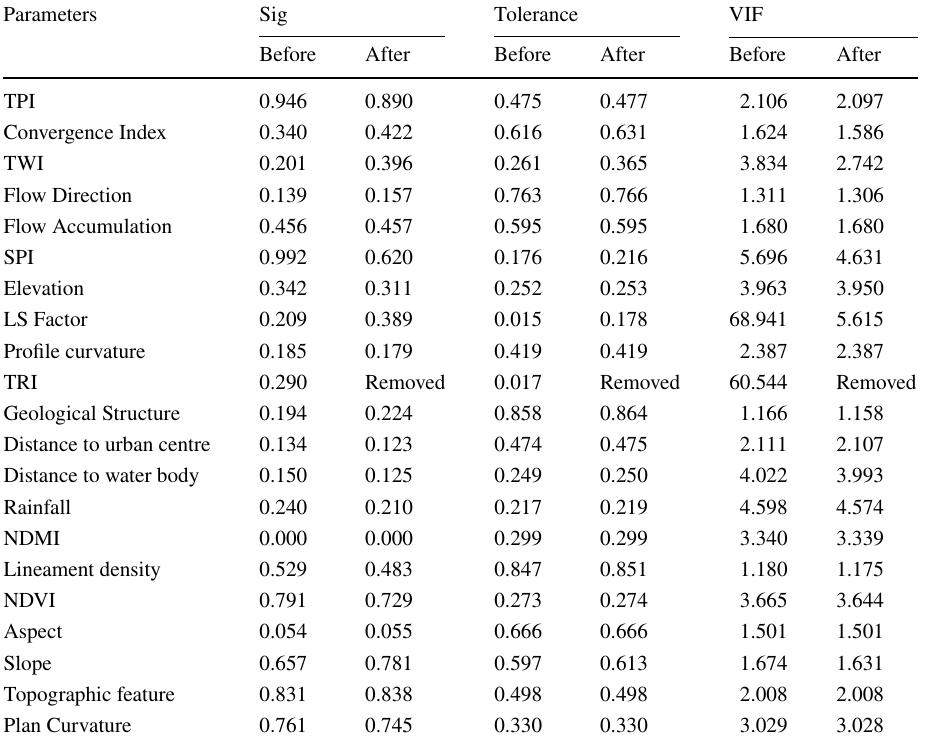
Table 2 The evaluation of the Parameters Sig Tolerance VIF flood conditioning factors using a multi-collinearity test (VIF) Before After Before After Before After before and after removal of redundant parameters